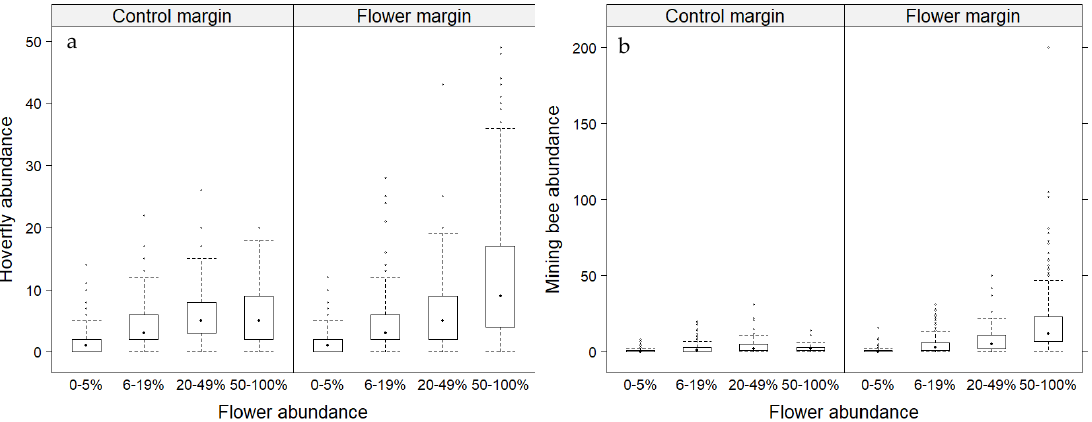
Figure 1. The average number of different pollinator groups observed in a 27 m 2 area (3 observations in a transect of 3 × 3 m) of control field margins and those planted with an Operation Pollinator seed mix (flower margin). The boxes are the interquartile range, the line in the box is the median and the cross is the average. The whiskers are 1.5 times the interquartile range and the dots are data points that fall outside that range.